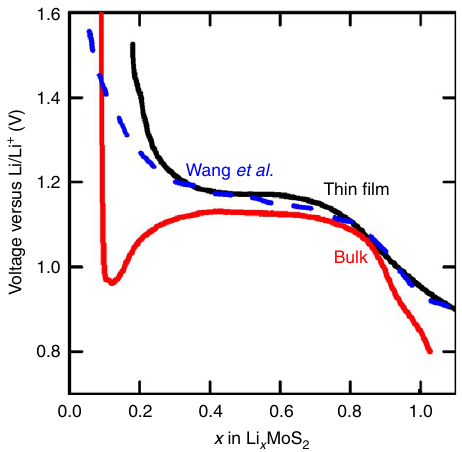
Figure 3 | Initial discharge curves for MoS 2 samples. Thin-film (black) and bulk (red) MoS 2 samples, compared with data by Wang et al. 55 (dashed line) for thin-film Li x MoS 2